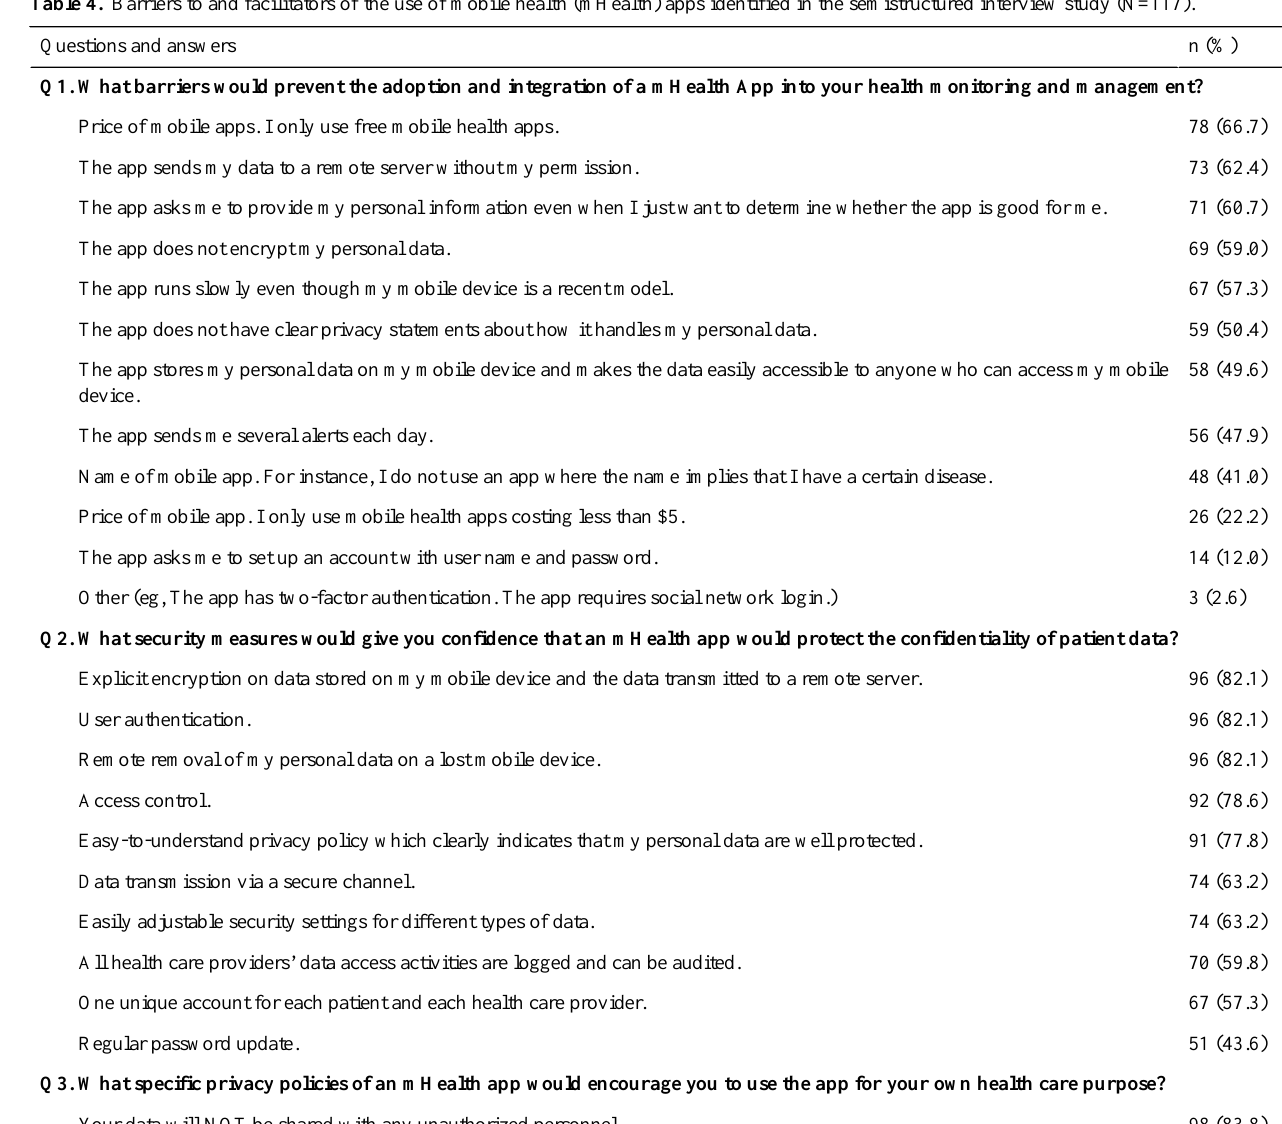
Table 4. Barriers to and facilitators of the use of mobile health (mHealth) apps identified in the semistructured interview study (N=117).